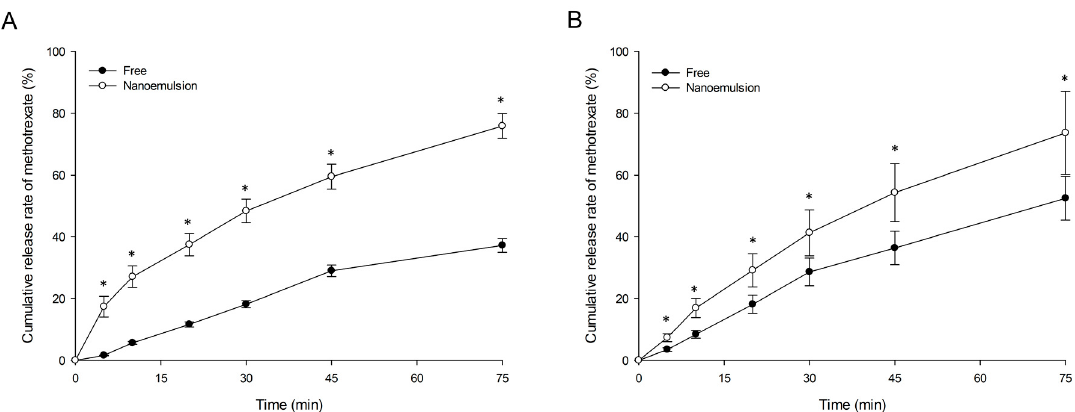
Figure 5. In vitro release profiles of free methotrexate and methotrexate-loaded nanoemulsion in pH 1.2 ( A ) and pH 7.4 ( B ) medium. Values are presented as the mean ± standard deviation ( n = 3). * p < 0.05 compared with free methotrexate.